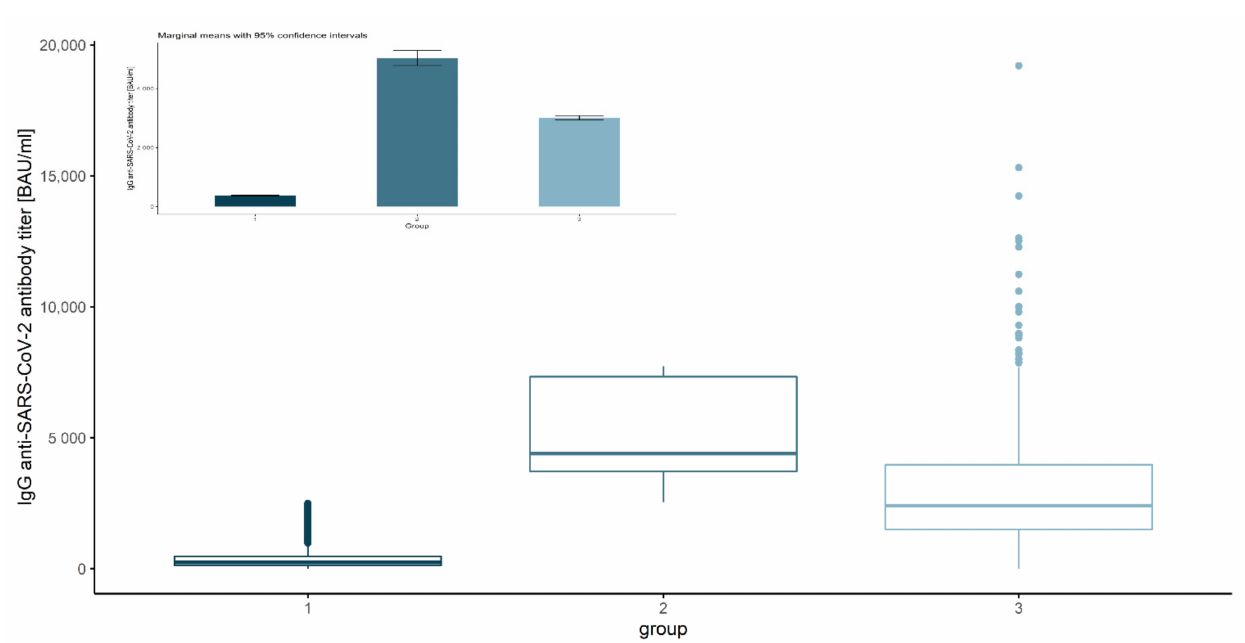
Figure 1. Comparison of anti-SARS-CoV-2 antibody levels by group without distinguishing among vaccines. Group 1 (dark blue box): 2 doses more than 6 months before measurement, low antibody level (<2500), regardless of the declaration of COVID-19 prior infection; group 2 (blue box): 2 doses more than 6 months before measurement, high antibody levels (>2500), no declaration of COVID-19 prior to infection; group 3 (light blue box): 3 doses, regardless of the declaration of COVID-19 prior to infection and antibody levels.